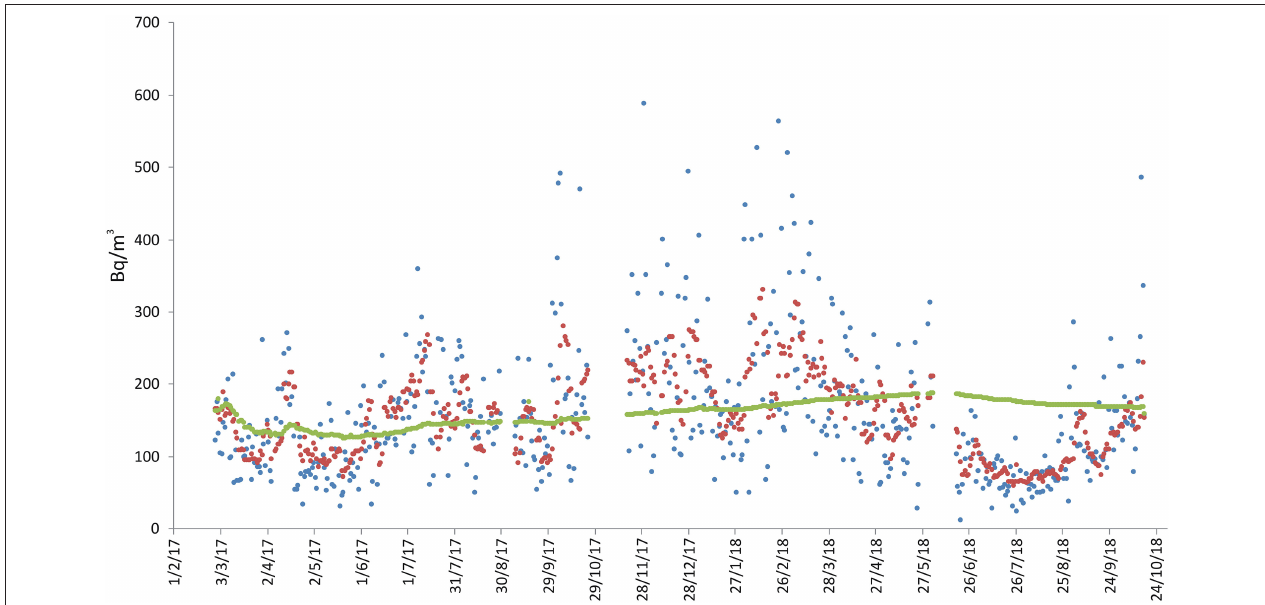
FIGURE 4 | Radon measurements recorded at location 3 (see Figure 1 , sensor 4), in the Zafferana Etnea territory. Radon concentration are presented as daily (blue line), weekly (red), and long-term (green) averages. No data interruption occurred during the acquisition period. The short discontinuities of the green line (long-term average) indicate only discontinuity in the data